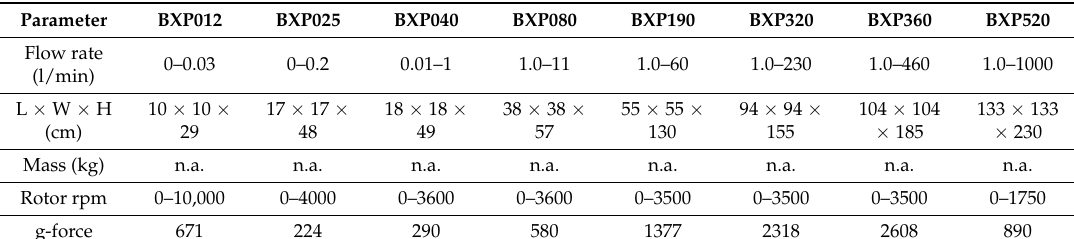
Table 2. Current model range of ROUSSELET ROBATEL extractive centrifuges [23].